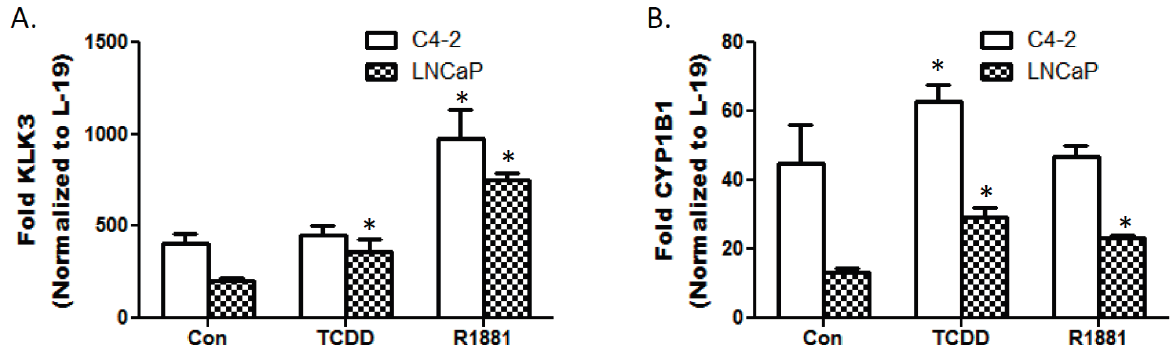
Figure 3. qRT-PCR analysis of KLK3 and CYP1B1 transcripts. Total RNAs were